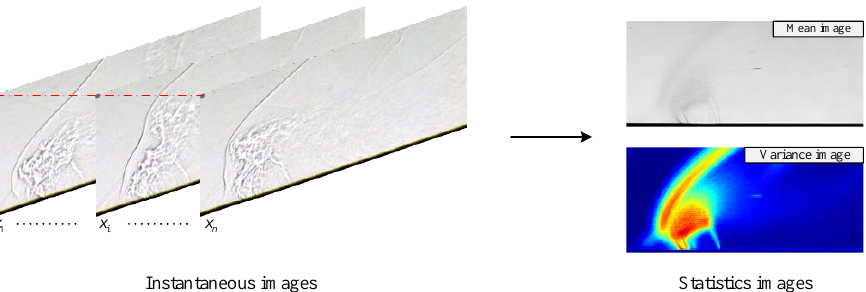
Figure 6. Schematic diagram of the image processing technique used to obtain the mean temporal